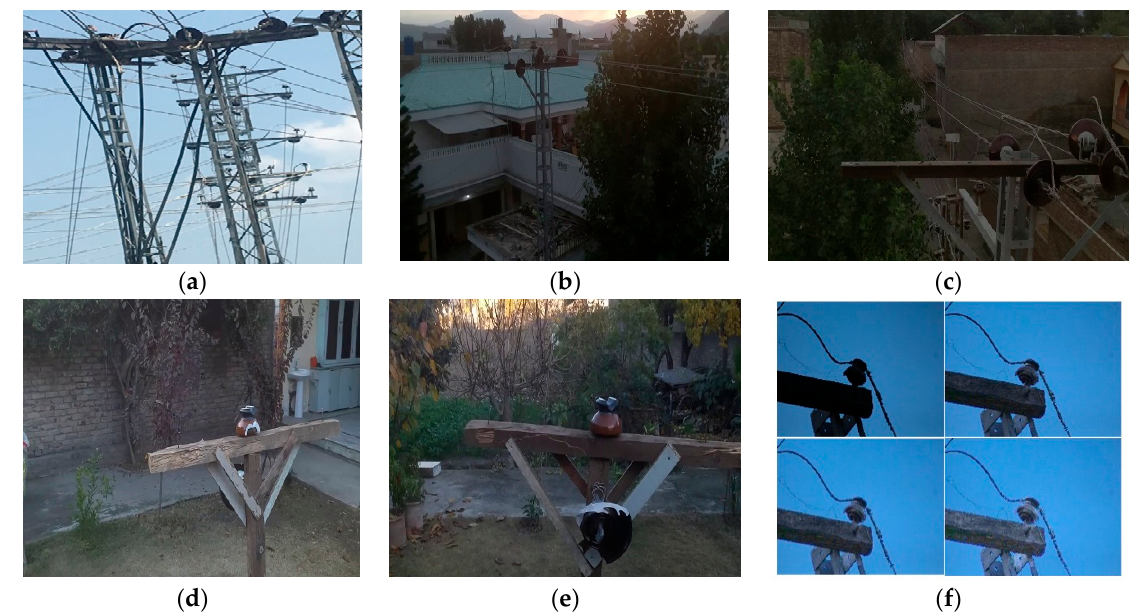
Figure A2. ( a ) Shuttering due to conductor and clipping wire. ( b ) Faulty insulator training image. ( c ) Normal insulator training image.